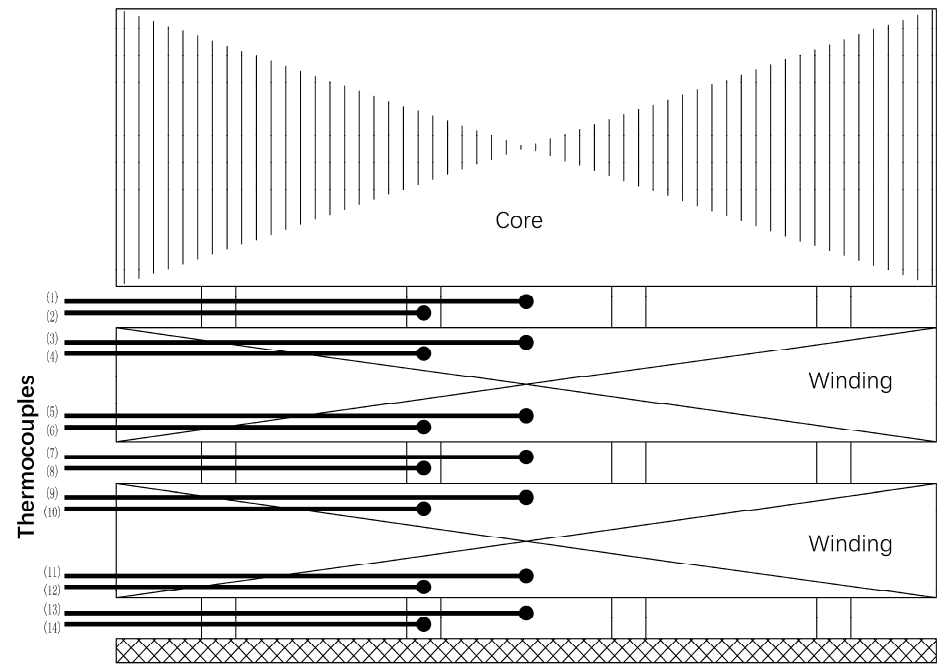
Figure 4. Thermocouple arrangement in an axial section (not drawn to scale). In the middle slot, two additional thermocouples were arranged separately inside the insulation and at the long side of the bars, that is, near the tooth. The two thermocouples are represented in Figure 5 and labeled as (15) and (16). The two points are placed here because we expected them to be hotter than the others.